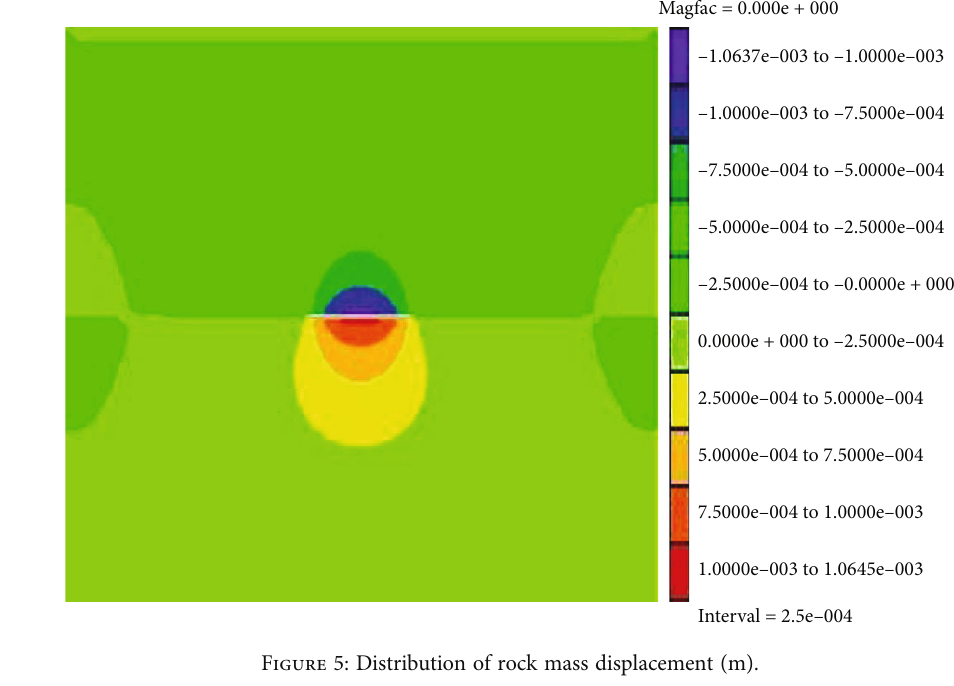
Figure 5: Distribution of rock mass displacement (m).